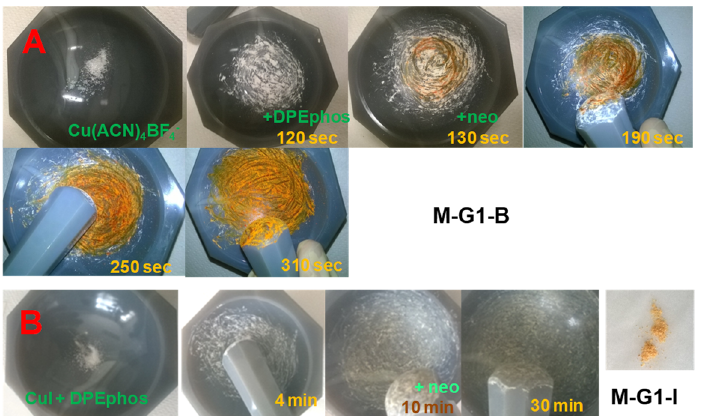
Figure 23. Mechanosynthesis of Cu-2 .BF 4 ( A ) and Cu-2 .I ( B ). Reproduced with permission from the authors of [104]. Copyright 2018 American Chemical Society.